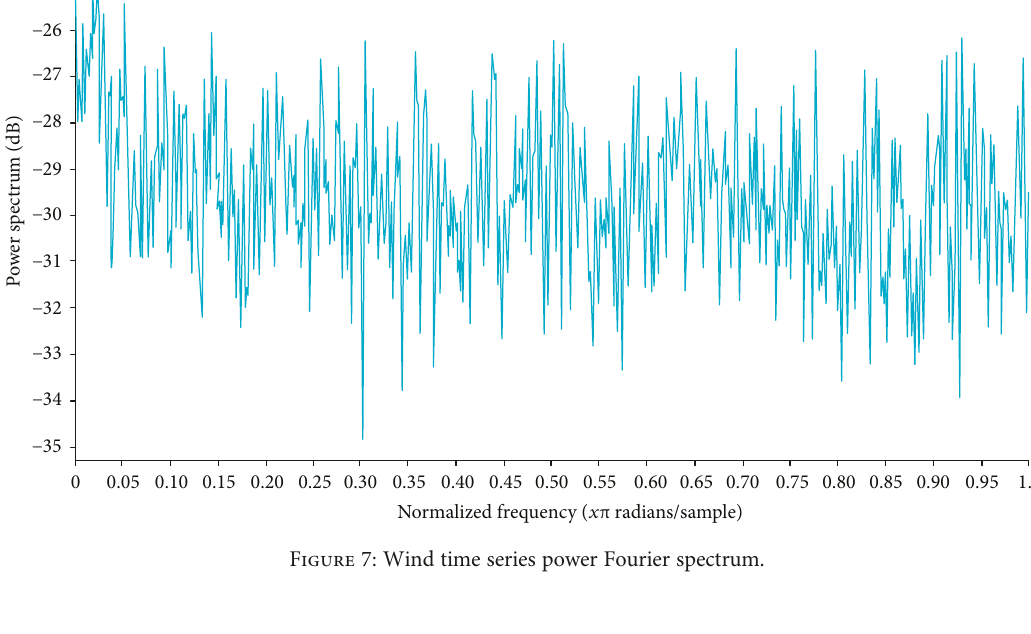
Figure 7: Wind time series power Fourier spectrum.